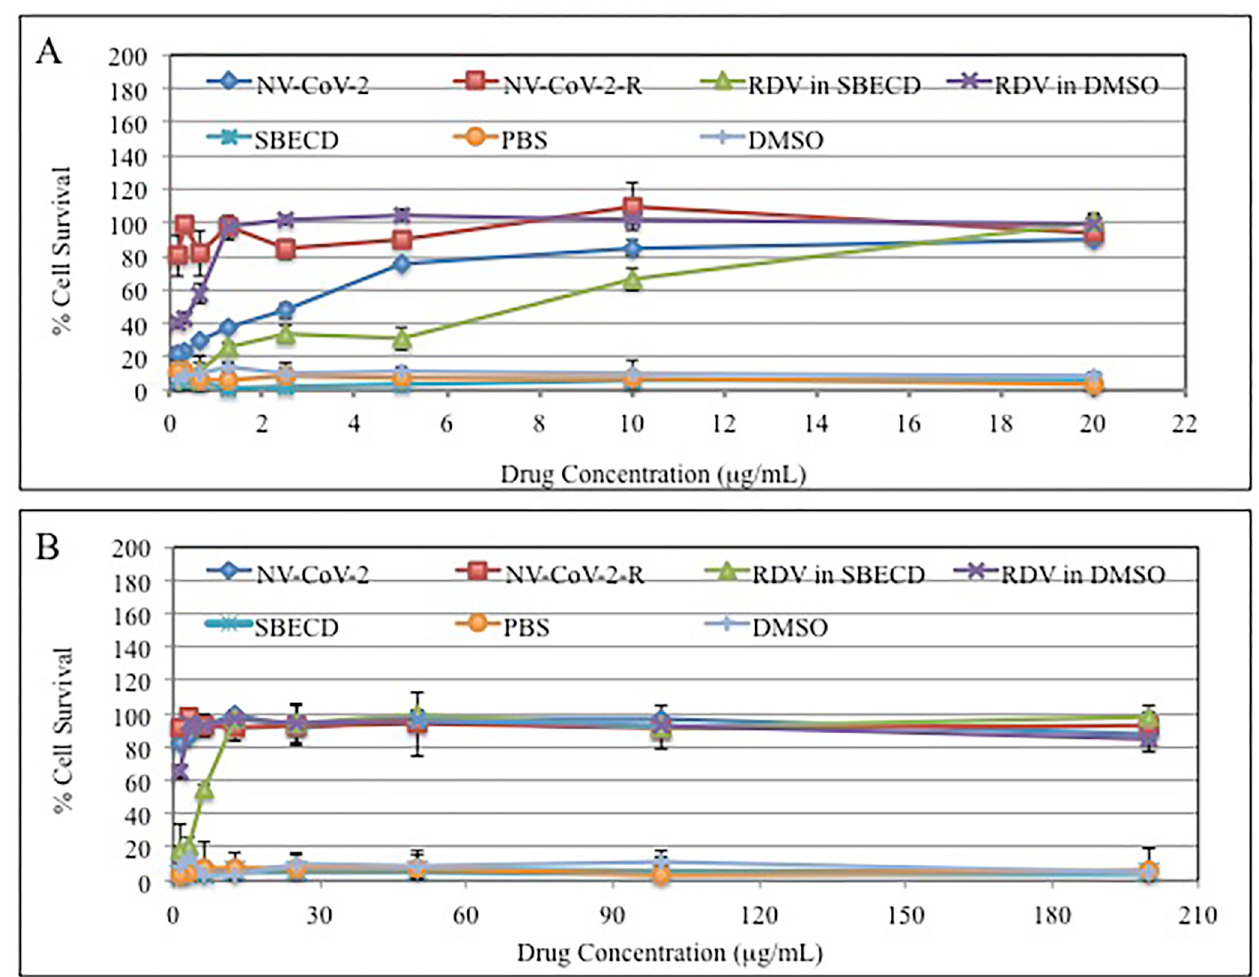
Fig 1. Antiviral effect of NV-CoV-2, NV-CoV-2-R and RDV in vitro . A: MRC-5 cells infected with CoV-229E virus; B: LLC-MK2 cells infected with NL63 virus. https://doi.org/10.1371/journal.pone.0278963.g001 In vitro antiviral activity of NV-CoV-2 (Fig 1) Dose-responsive antiviral effects of NV-CoV-2, NV-CoV-2-R and RDV were observed as a protection of MRC-5 cells or LLC-MK2 cells infected with CoV-229E virus (A) or CoV-NL63 (B) virus, respectively. Antiviral efficacy is in the following order with MRC-5 cells: RDV � NV-CoV-2-R < NV-CoV-2. For the cells, LLC-MK2, the order of antiviral capacity are: RDV = NV-CoV-2-R = NV-CoV-2. PBS and DMSO, as a negative control do not show any antiviral capacity in either case.